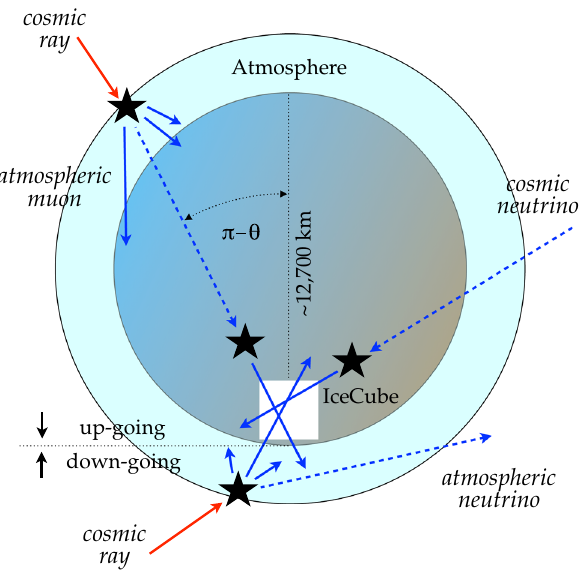
Fig. 4 Summary of neutrino observations with IceCube (per flavour). The black and grey data shows IceCube’s measurement of the atmo- spheric ν e + ν e [21,22] and ν μ + ν μ [23] spectra. The green data show the inferred bin-wise spectrum of the four-year high-energy starting event (HESE) analysis [24,25]. The green line and green-shaded area indicate the best-fit and 1 σ uncertainty range of a power-law fit to the HESE data. Note that the HESE analysis vetoes atmospheric neutrinos, and the true background level is much lower as indicated in the plot. The red line and red-shaded area indicate the best-fit and 1 σ uncertainty range of a power-law fit of the up-going muon neutrino analysis